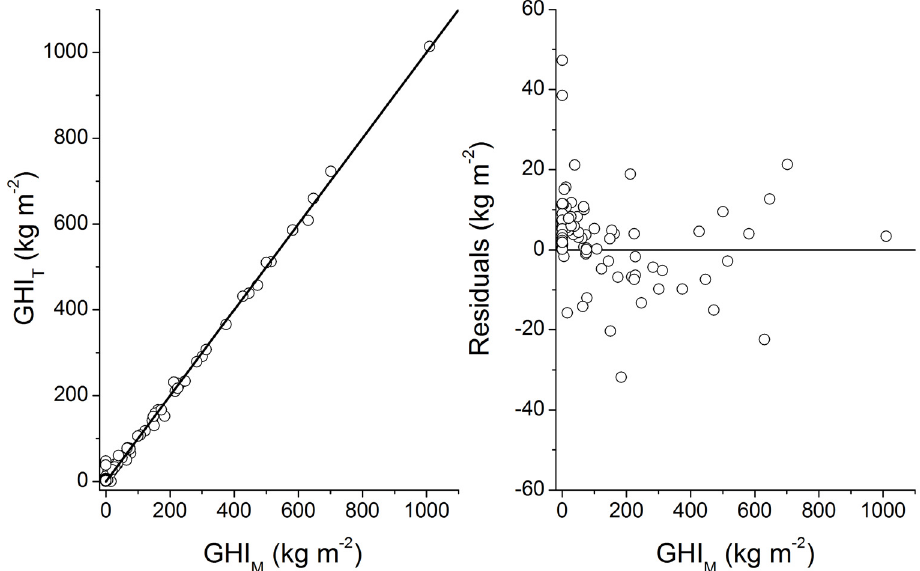
Figure 18. Gas hydrate inventories (GHI in kg m − 2 ) within the GHSZ calculated by , s. Figures 16,17) and with the individual runs of the transport- reaction model (GHI M , Equation (31)] for the same set of parameter values. The solid line transfer function [GHI T shown in the left panel has a slope of unity and serves as a reference for the transfer –GHI function values. The residuals shown in the right panel are calculated as GHI T M